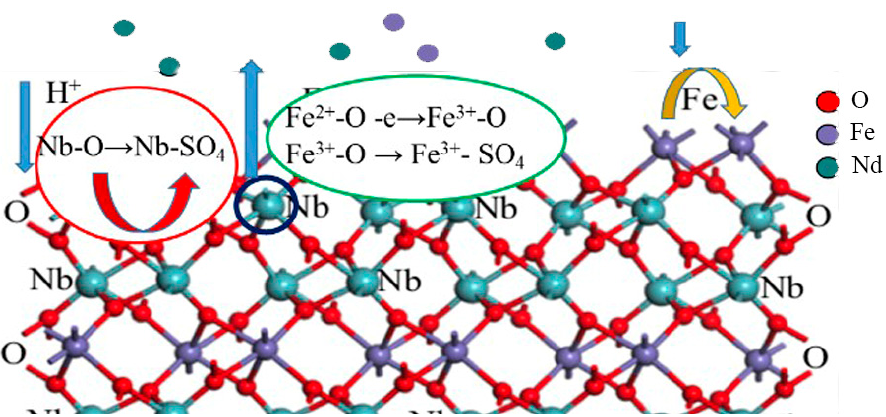
Figure 8. Surface structure control reactivity and dissolution with H 2 SO 4 acid leaching.